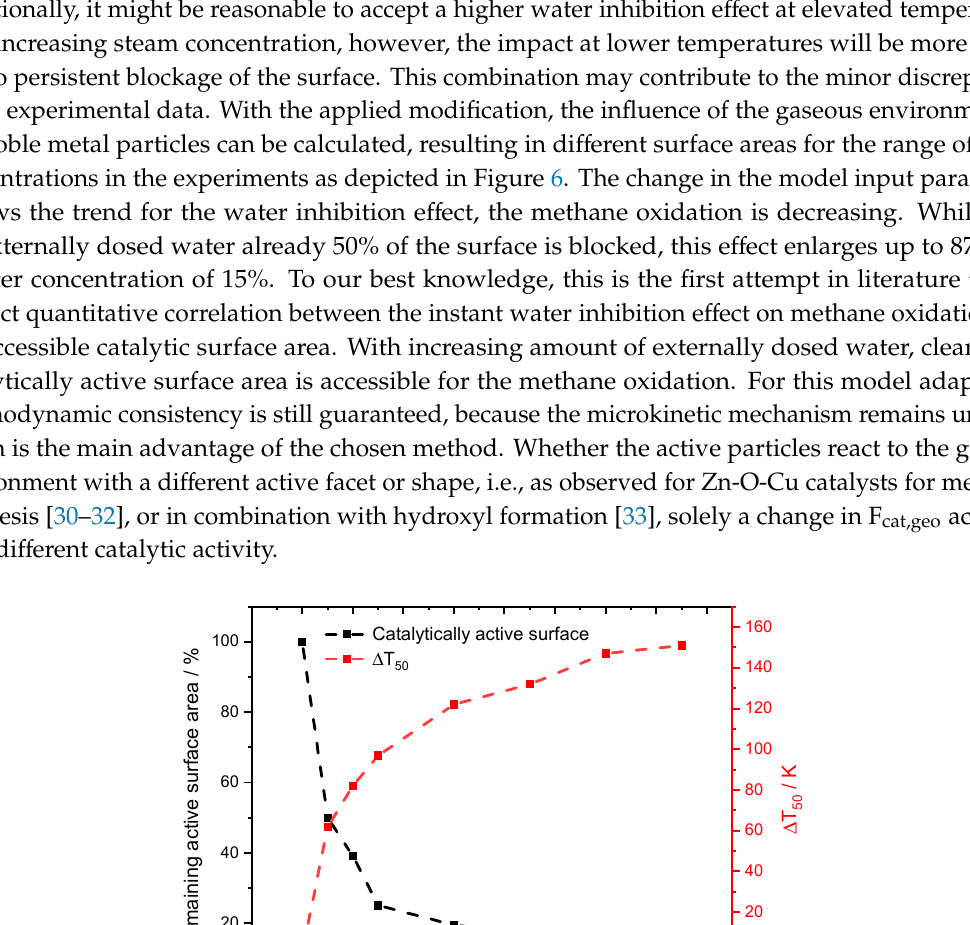
the experimental shift in T 50 for the light-o ff measurements in absence and presence of externally Figure 6. Results for the obtained change of the catalytically active surface area in comparison to the